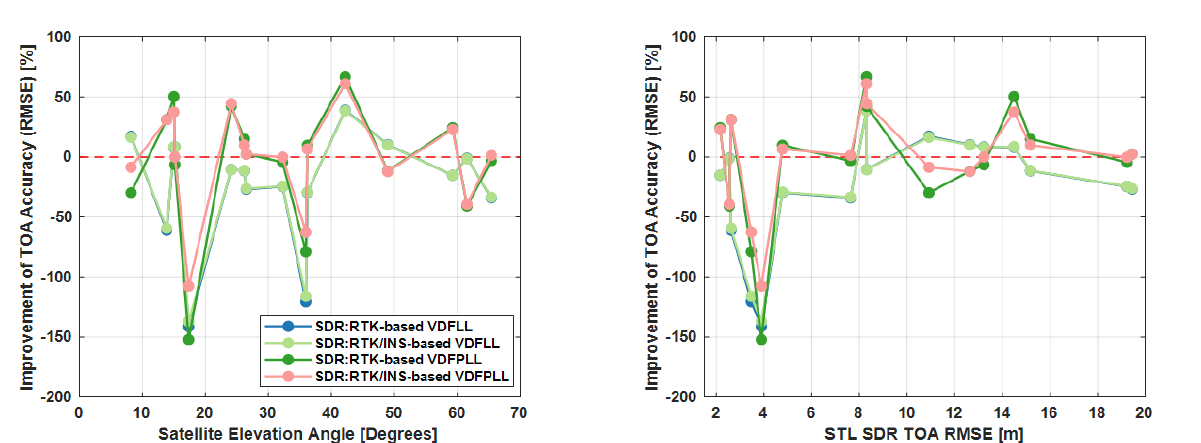
Figure 17. Comparison of TOA accuracy improvements varying with the satellite elevation angles and the TOA errors (positive and negative values represent the improved and reduced performance percentages, respectively).